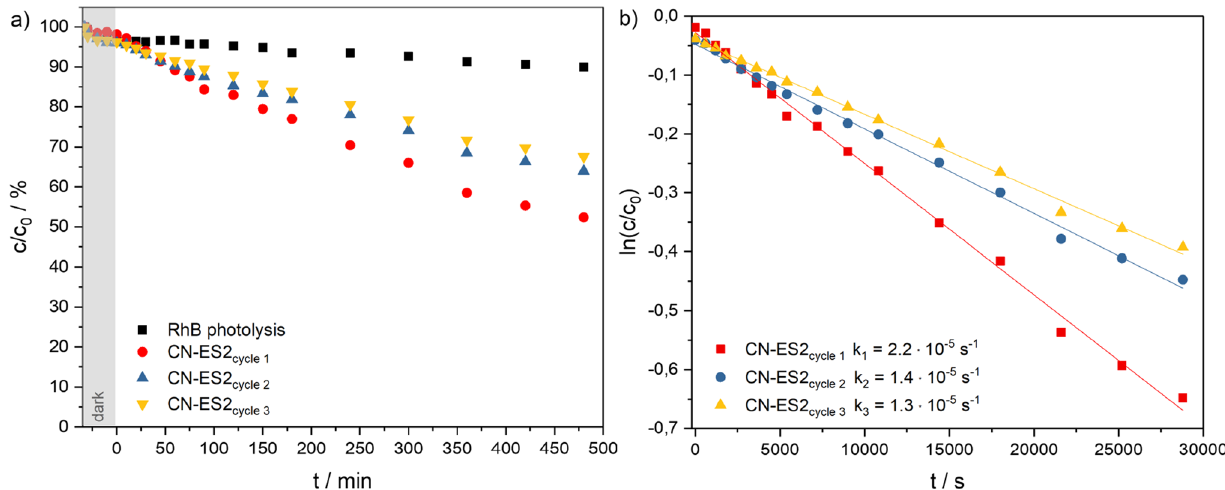
Fig. 7 a Time-dependent cycling experiment for the photodegra- dation of an aqueous RhB solution (1 × 10 -5 M) under visible light irradiation with a 300 W Xe-lamp (t > 0 min) without catalyst and